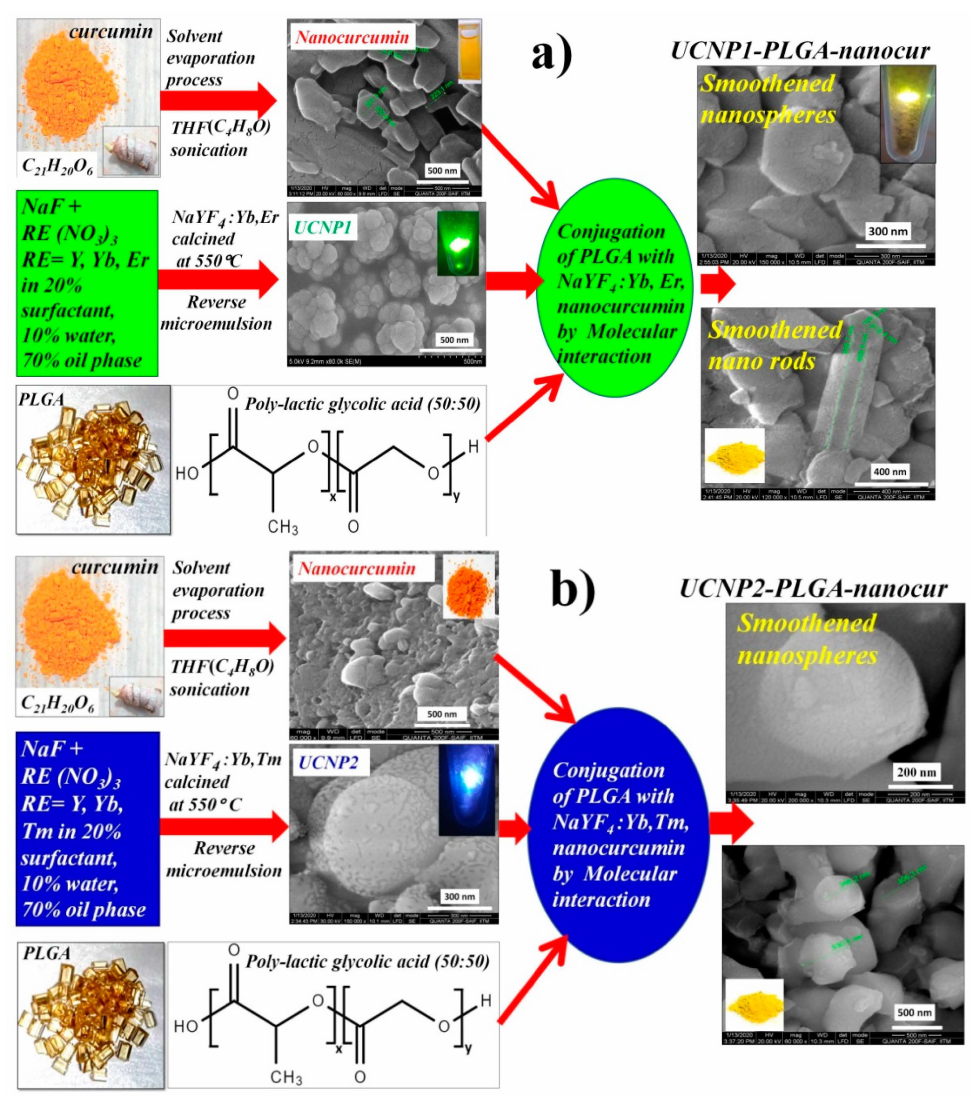
Figure 1. Formation mechanism of ( a ) UCNP1-PLGA-nanocur, ( b ) UCNP2-PLGA-